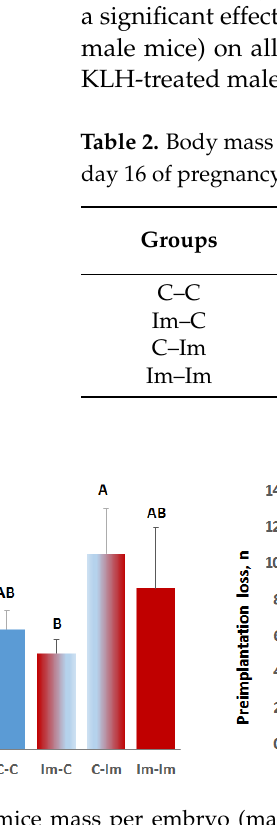
Figure 3. Female mice mass per embryo (mass/litter size) ( A ) and embryo losses at pre- ( B ) and post-implantation (resorption) ( C ) stages of pregnancy in the C–C, Im–C, C–Im, and Im–Im experimental groups. Note that the letters above indicate significantly different mean values (LSD test, p < 0.05). Table 3. Two-way ANOVA of the effects of male immunization (injection with KLH) on the per-embryo female mass and pre- and post-implantation embryo losses.